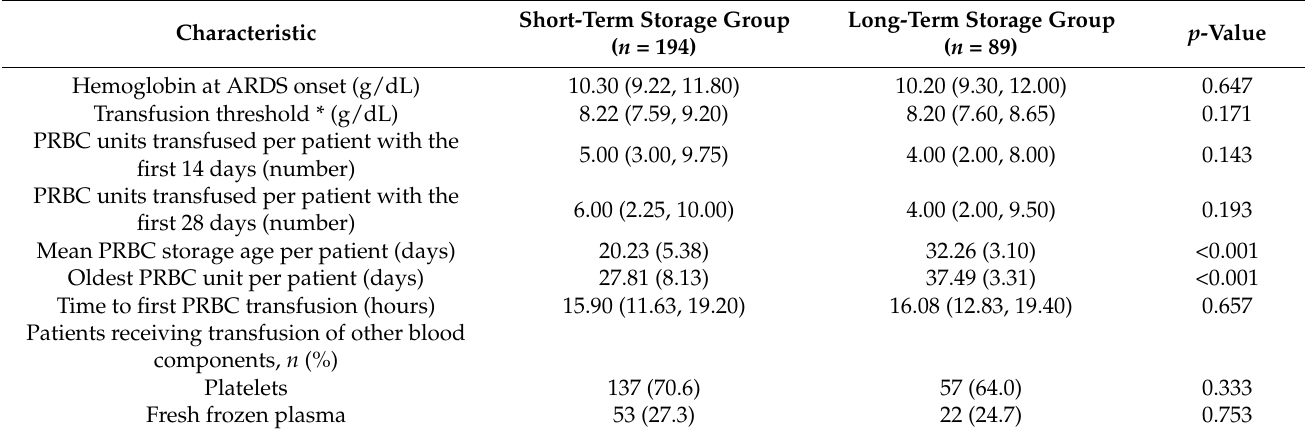
Figure 2. Transfusion characteristics of the short-term and long-term storage groups. The hemoglobin concentrations at ARDS onset ( A ), the transfusion threshold (pre-transfusion hemoglobin) ( B ), the time from ARDS onset to transfusion of the first PRBC unit ( C ), the number of transfused PRBC units within 14 days of ARDS therapy ( D ), and the distribution of the storage age in both groups ( E ) are presented. The mean storage (SD) in each group and the mean difference between the groups is indicated. Table 2. Transfusion characteristics of the